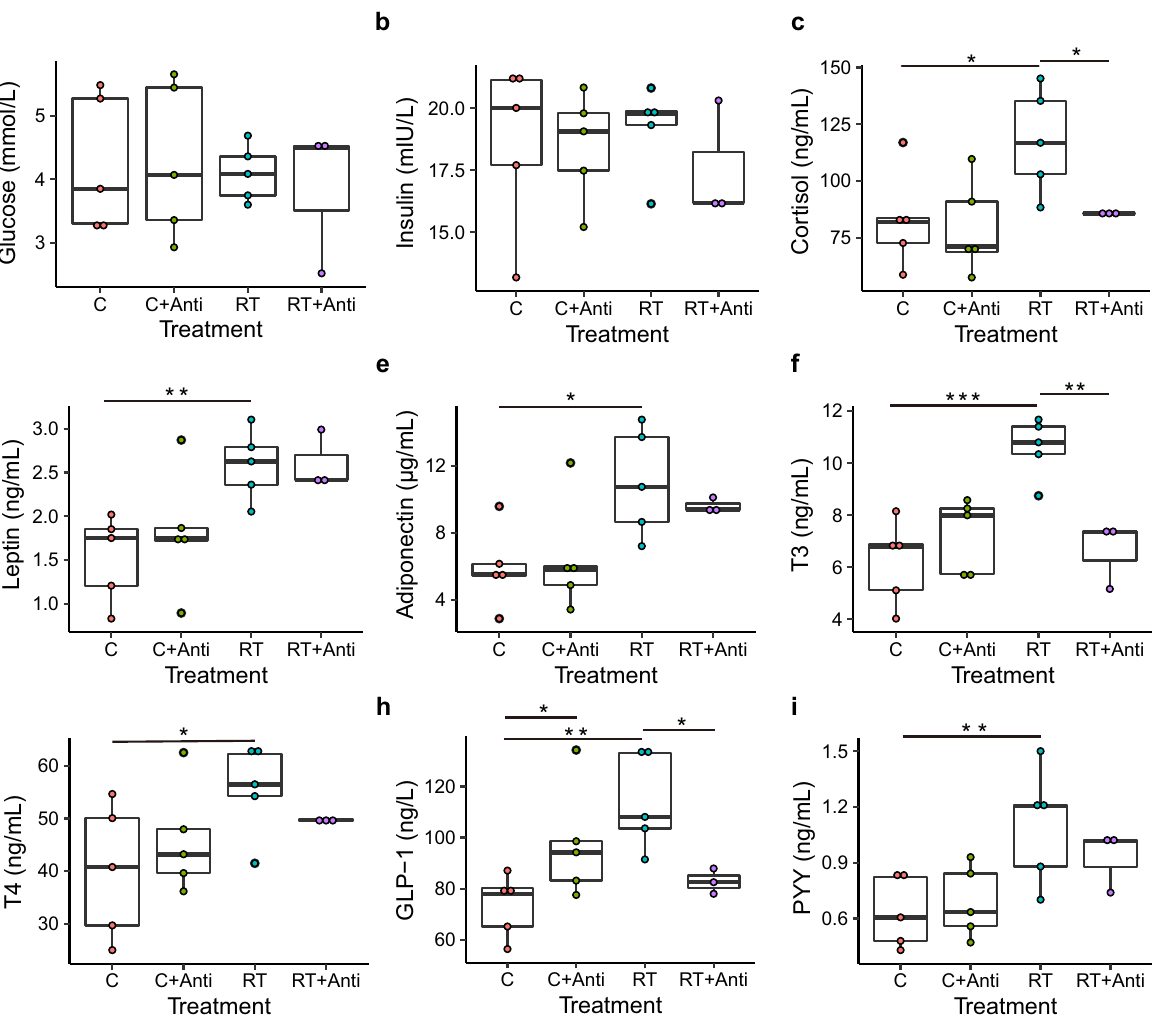
Fig. 1 Effect of cold stress on the serum characteristics of piglets. a Glucose level in serum. b Insulin level in serum. c Cortisol level in serum. d Leptin level in serum. e Adiponectin level in serum. f Triiodothyronine (T3) level in serum. g Thyroxine level in serum. h Glucagon-like peptide-1 (GLP-1) level in serum. i Peptide YY (PYY) level in serum. C, C + Anti, RT, and RT + Anti represent the cold stress, cold stress with antibiotics, room temperature, and room temperature with antibiotics groups, respectively. The data are the means ± SEMs ( n = 3 or 5 per group). Statistical signi fi cance was determined using Wilcoxon test (* p < 0.05, ** p < 0.01, *** p <